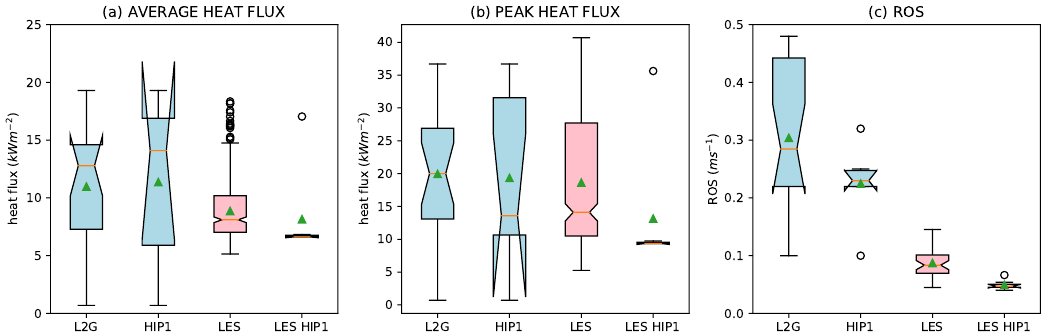
Figure 3. Comparison of observed (blue) and modeled (red) fire behavior. The box and whiskers span interquartile range (IQR) and 1.5 × IQR, respectively, with the notch denoting the 95% confidence interval of the median (median ± 1.57 × IQR/n 1/2 ). Red line and green triangle correspond to median and mean, respectively. ( a ) Average heat flux during flaming period. ( b ) Peak fire heat flux during flaming period. ( c ) Rate of